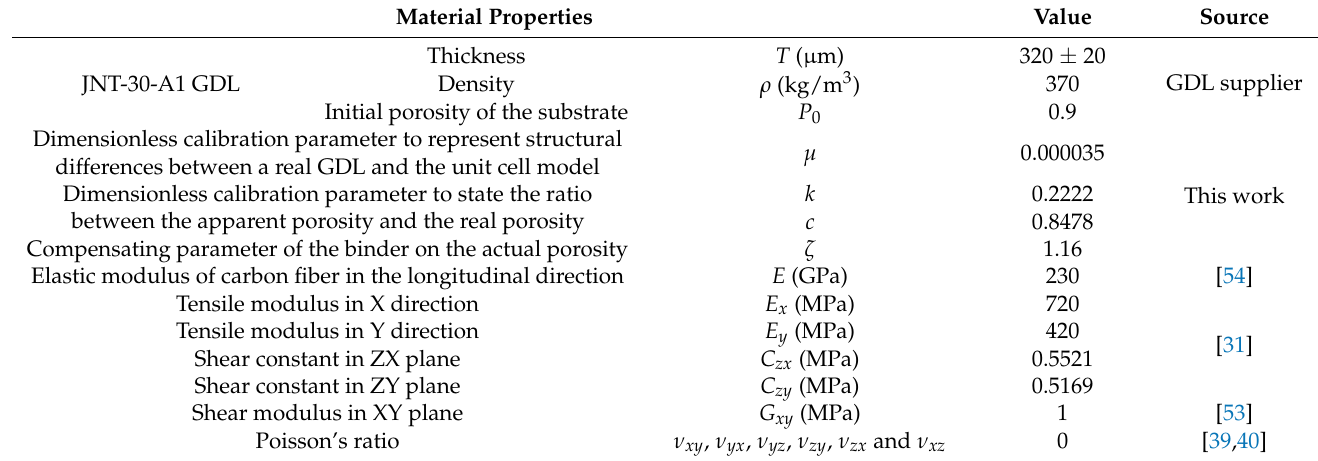
Table 1. Material specifications of a GDL and property parameters of the 3-D nonlinear and orthotropic constitutive